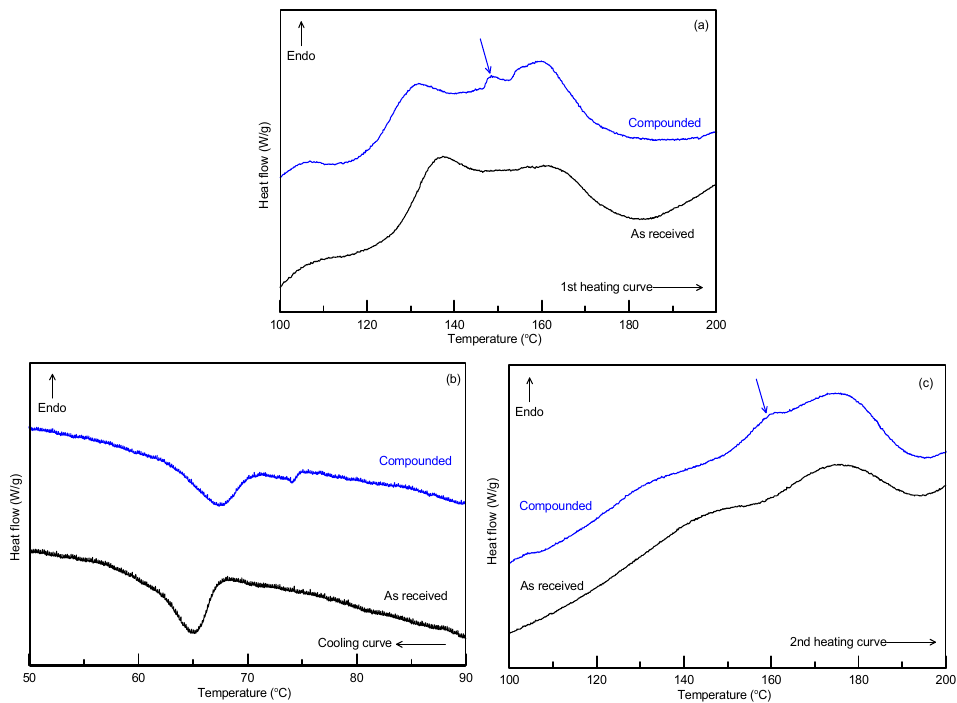
Figure 3. Comparison of DSC curves of TPU pellet as received and compounded: ( a ) first heating, ( b ) cooling and ( c ) second ( b ) cooling and ( c ) second heating.